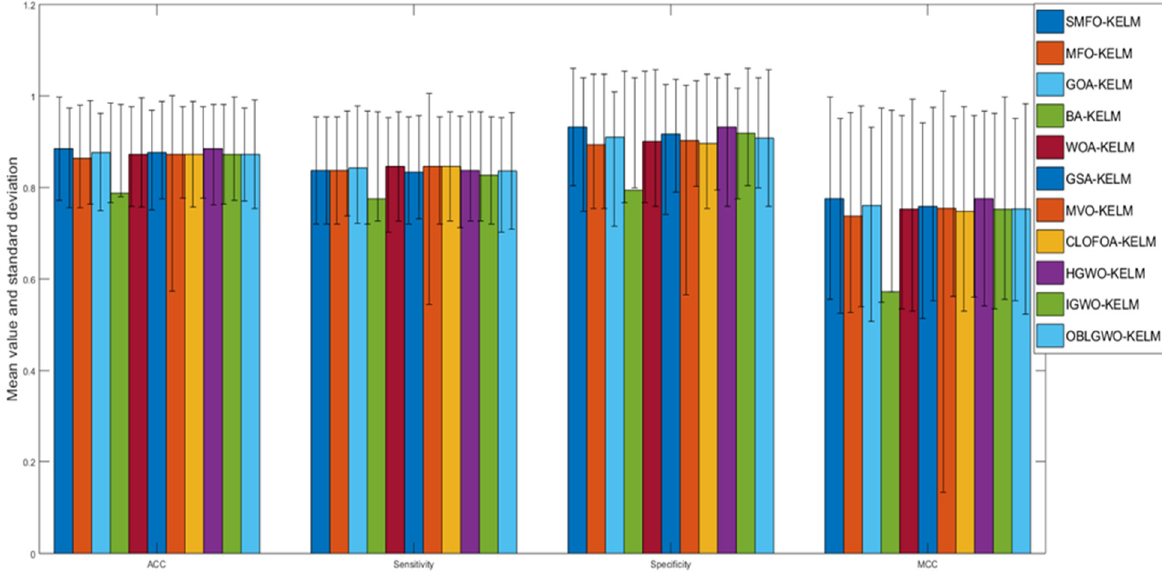
Figure 8. Bar of SMFO-KELM and other competitors in terms of ACC, MCC, sensitivity, and specificity on the dataset.